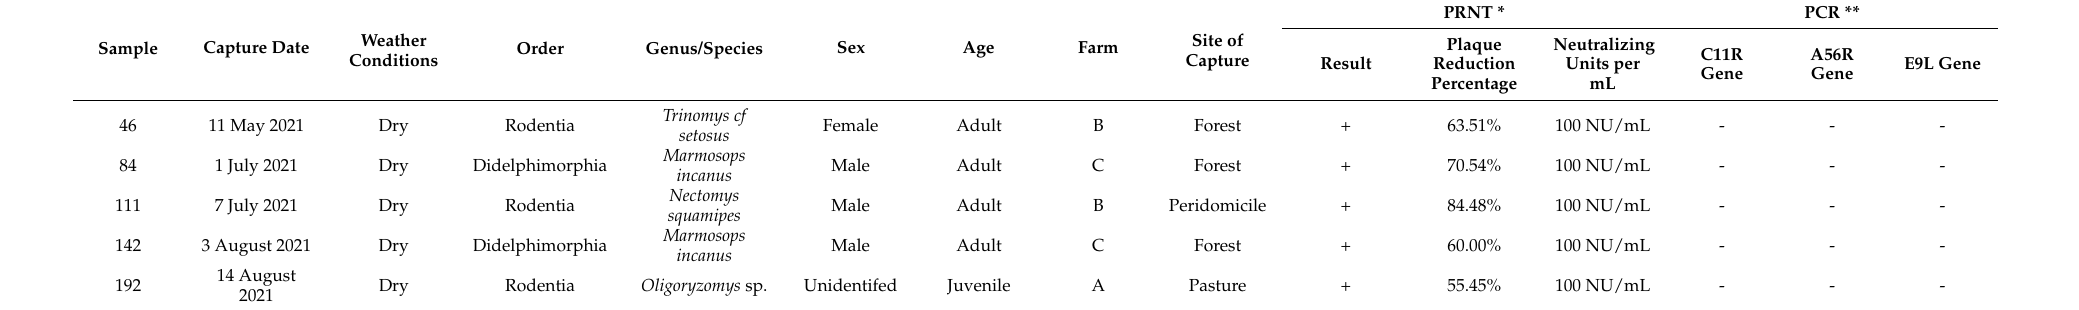
Table 1. Captured animals’ data with positive results in PRNT